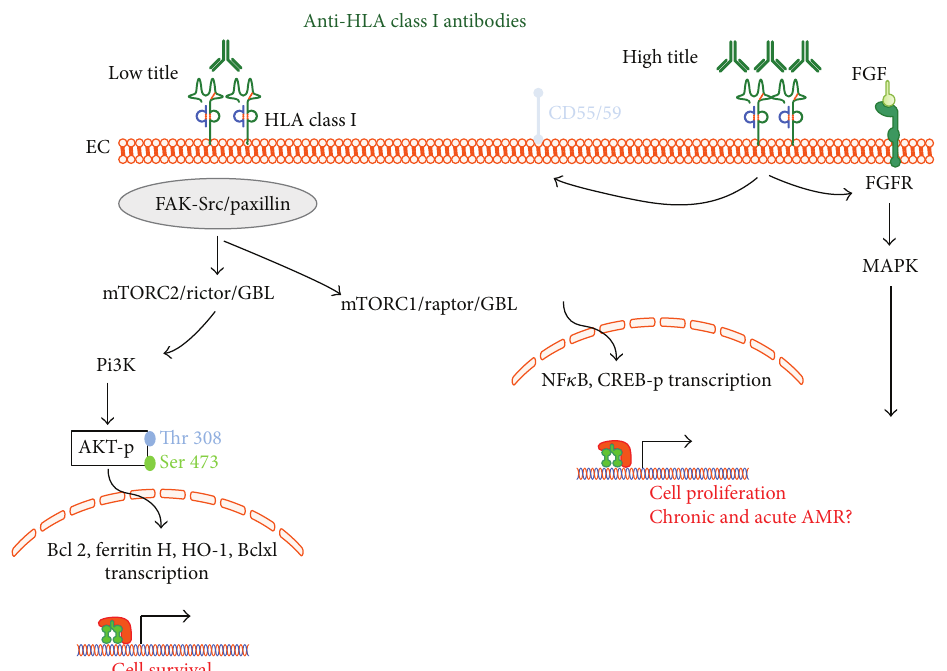
Figure 2: Intracellular signalling pathways mediated by high/low titre HLA class I antibodies after endothelial binding. Putative cell survival and proliferation pathways are illustrated.